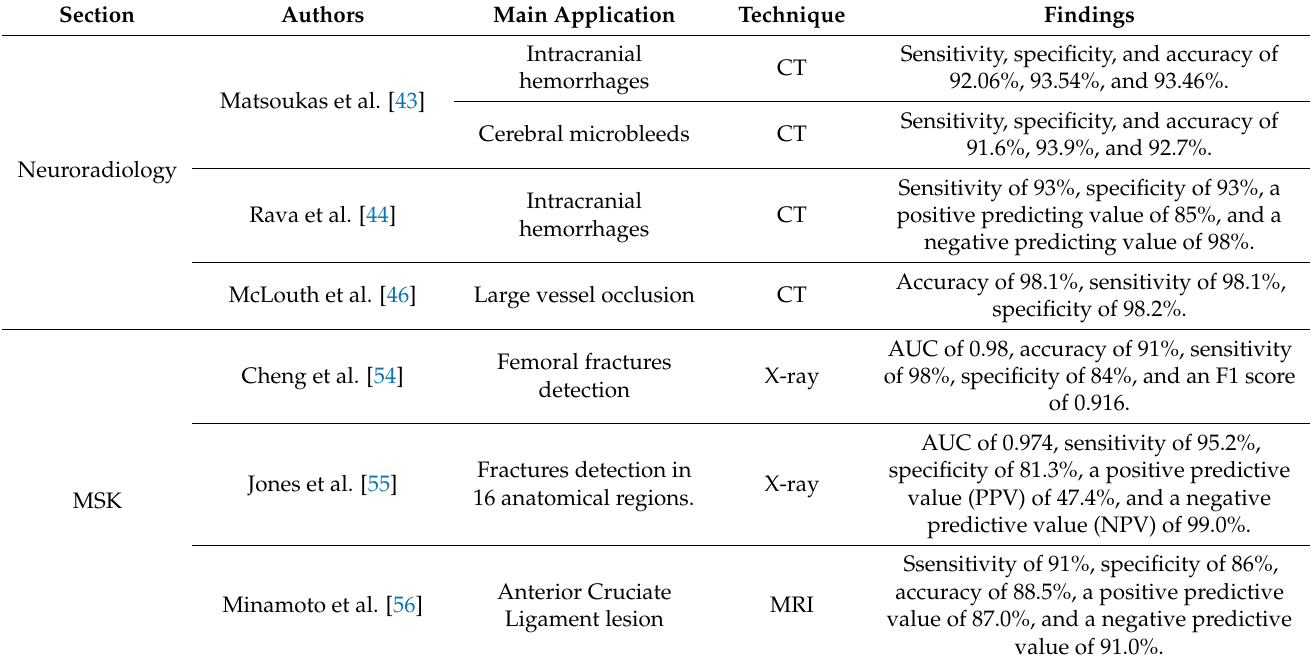
Table 2. This table sums up the main results from the studies investigating the different applications of AI tools for automatic disease